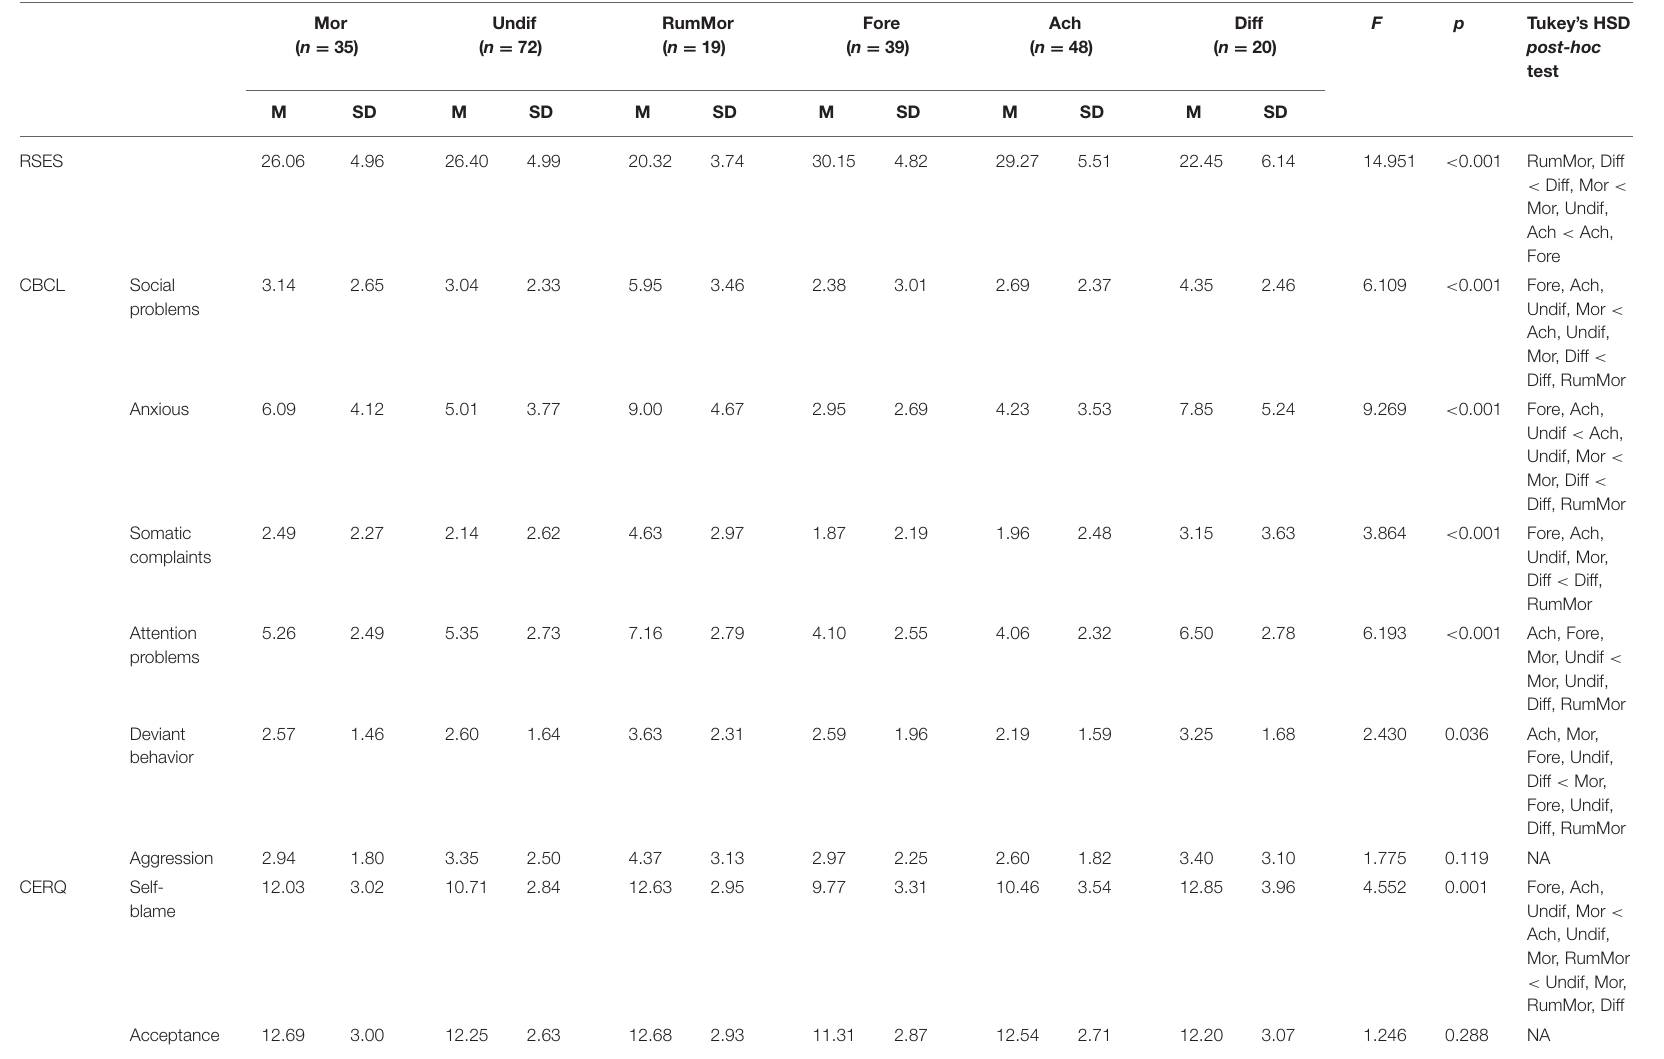
TABLE 5 | Comparison of the six H-DIDS clusters on the measured variables; results of